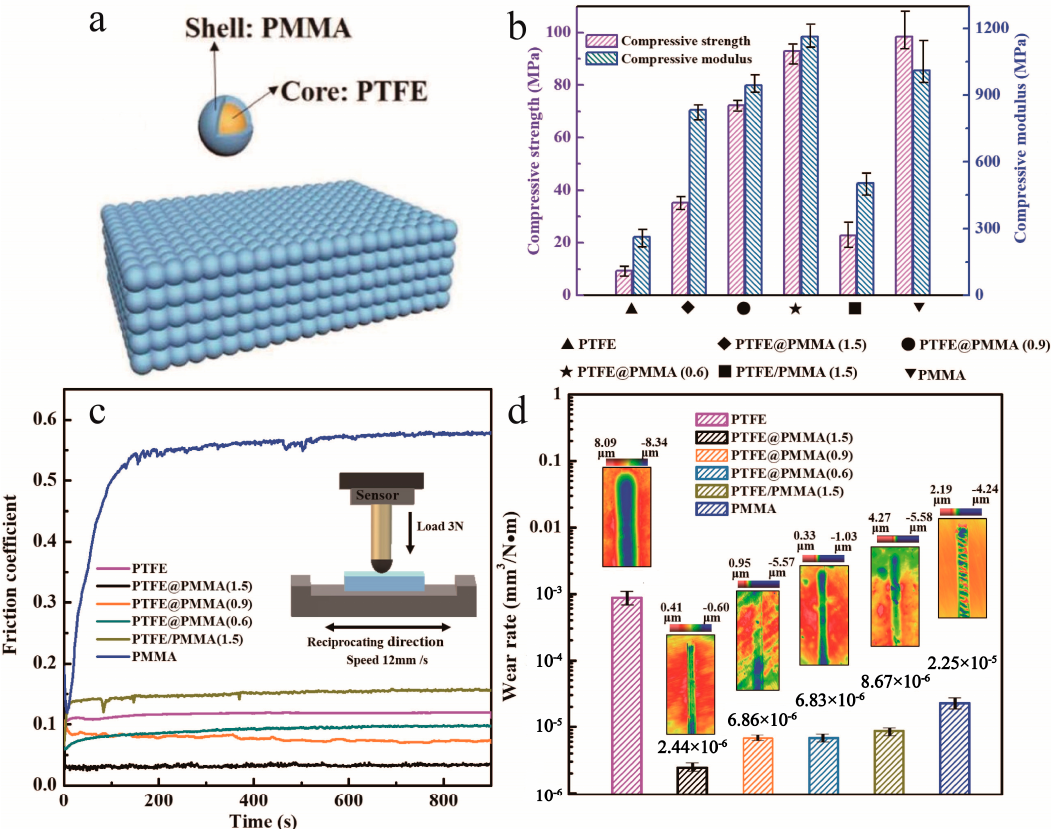
Figure 19. ( a ) Microstructural diagram of the PTFE@PMMA composite, ( b ) compression curves of the specimens, ( c ) variations in the friction coefficients of the test specimens over time, ( d ) white light interferometry images and wear rates of the specimens [105]. Reproduced with permission from [Lin Zhang et al.], [Nanoscale]; published by [Royal Society of Chemistry], 2019.